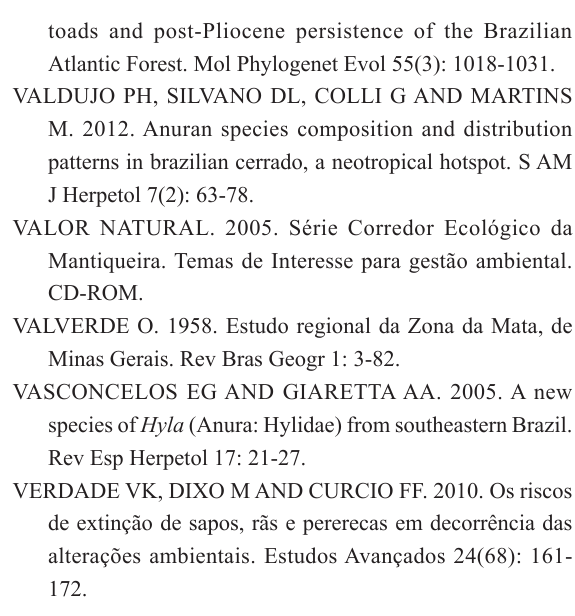
TABLE SI - Endemic species of Serra da Mantiqueira complex and South of Serra do Espinhaço and the status of conservation according to the International Union for Nature Conservation (IUCN 2016), the list of Brazilian endangered animals from the Instituto Chico Mendes de Conservação da Biodiversidade (ICMBio 2014), and the lists from Minas Gerais State (Drummond et al. 2008), Rio de Janeiro State (Bergallo et al. 2000), São Paulo State (Bressan et al. 2009), and Espírito Santo State (Passamani and Mendes